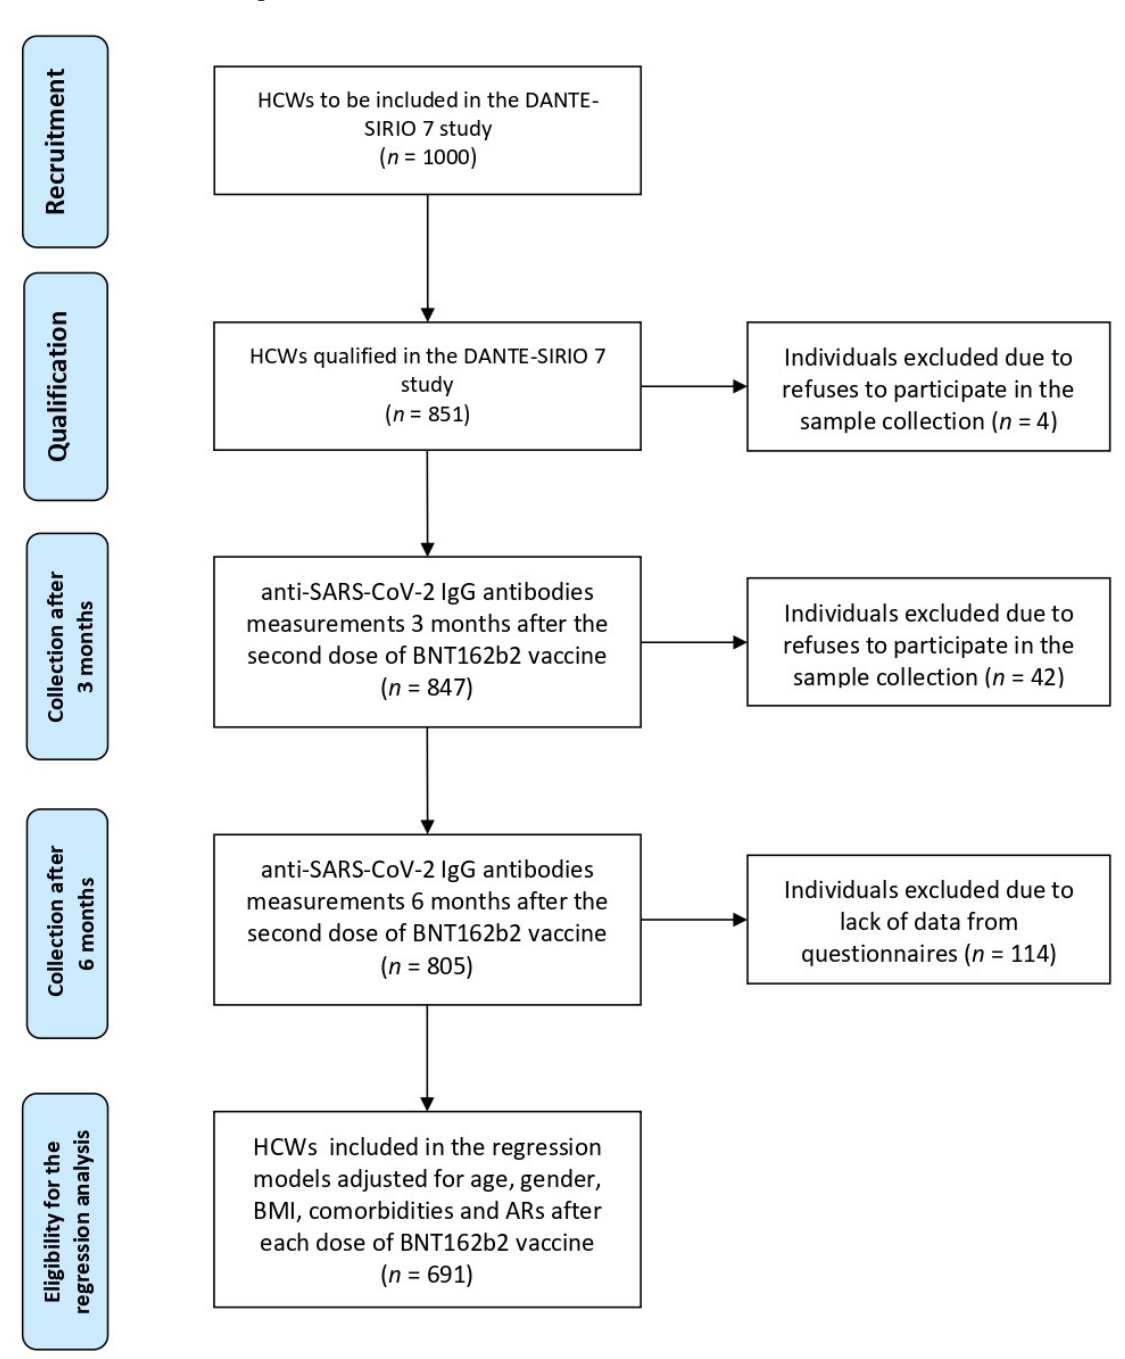
Figure 1. Flowchart for selection of the study participants. HCWs, healthcare workers.